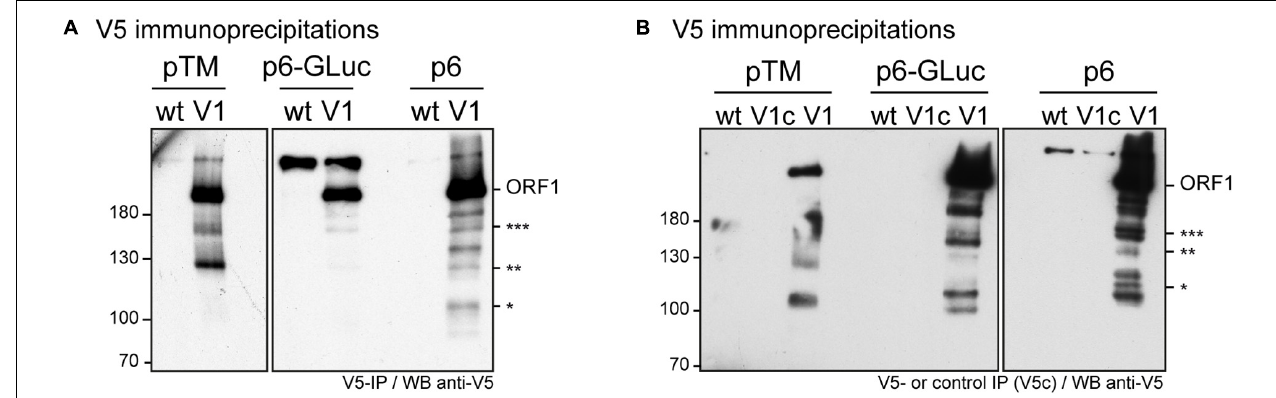
FIGURE 4 | Immunoprecipitation of the V5-tagged ORF1 protein expressed in different cellular systems. (A) HEV p6 ORF1 protein was heterologously expressed in H7-T7-IZ cells following transfection with the pTM plasmid carrying the untagged (wt) or V5-tagged (V1) construct (left panel). One dpt, total cell lysates were immunoprecipitated with the polyclonal goat anti-V5 antibody. HEV p6 protein was expressed in the replicon (p6-GLuc) and p6 cell culture (p6) systems (right panel). Three dpe, PLC3 cells lysates expressing either the untagged (wt) or the V5-tagged (V1) ORF1 proteins were immunoprecipitated using the polyclonal goat anti-V5 antibody. Immunoblots were revealed with a mouse anti-V5 monoclonal antibody. Molecular weight markers are indicated in kilodaltons. Stars indicate lower molecular weight ORF1 products. (B) In the same conditions as above, the control immunoprecipitations were conducted on the lysates expressing the V5-tagged ORF1 in all three systems using protein G sepharose beads without antibody (lanes V1c). The other lanes are labeled as in panel (A) . Molecular weight markers are indicated in kilodaltons. Stars indicate lower molecular weight ORF1 products.